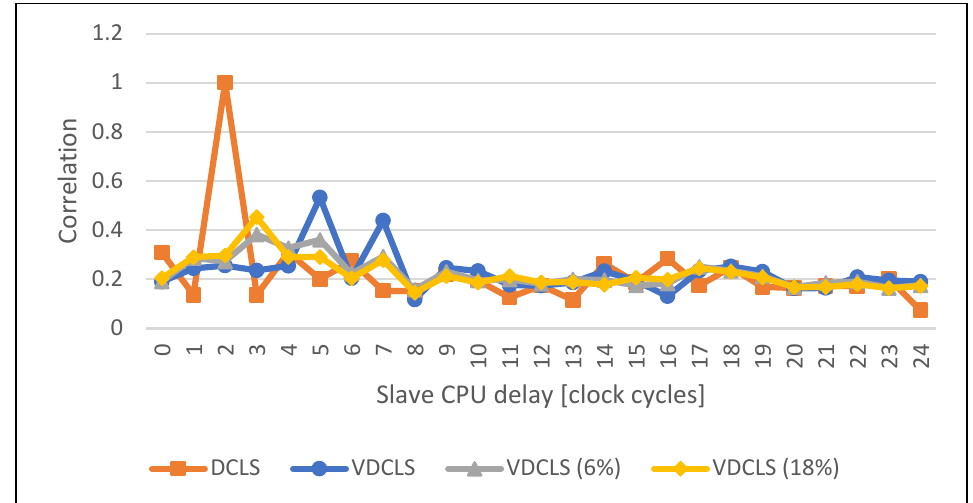
Figure 19. Comparison of the execution correlation between master and slave CPUs using VDCLS with dummy cycles insertion and legacy DCLS technique while executing the ECDSA verification algorithm.